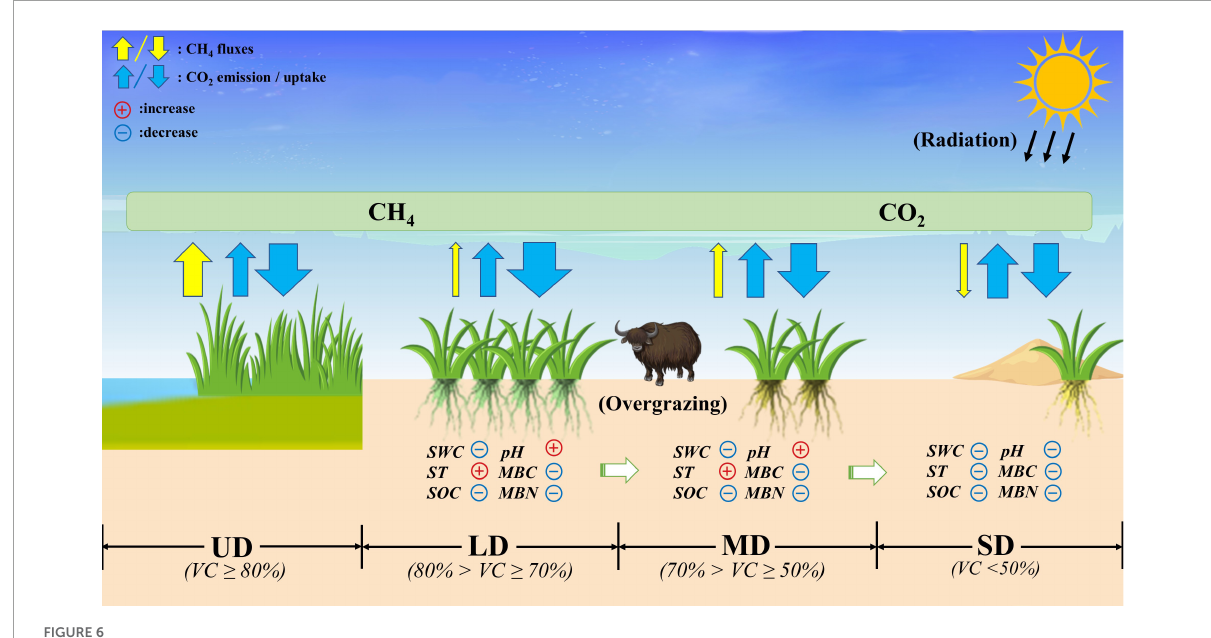
FIGURE6 Carbon budget and environmental factors in the Zoige alpine wetlands under different degradation gradients. UD, undegraded wetland; LD, lightly degraded wetland; MD, moderately degraded wetland; SD, severely degraded wetland; SWC, soil water content; ST, soil temperature at the 5 cm depth; SOC, soil organic carbon; MBN, microbial biomass nitrogen; MBC, microbial biomass carbon; VC, vegetation